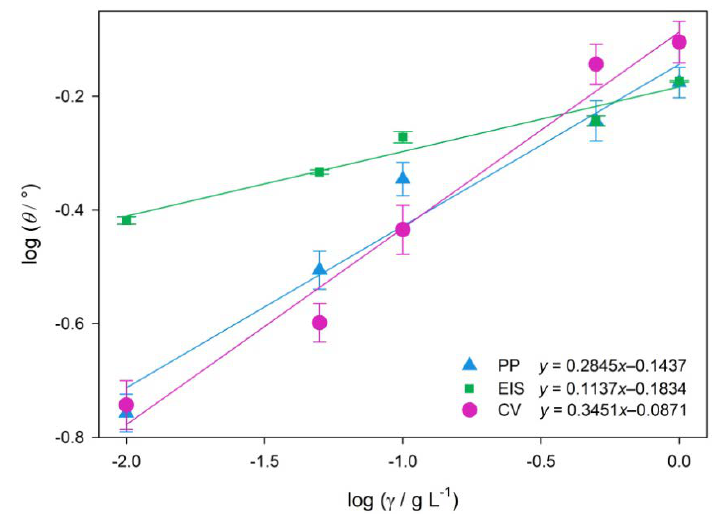
Figure 5 . Freundlich isotherms of adsorption of A. annua extracts on Al alloy 5083 surfaces in ASW. The adsorption constant, K, and the Gibbs free energy, ΔG , determined from PP, EIS and CV data using Equation (7) , were as follows: K = 0.718 and ΔG = −16.30 kJ mol − 1 (PP), K = 0.655 and ΔG = −16.07 kJ mol − 1 (EIS), K = 0.818 and ΔG = −16.62 kJ mol − 1 (CV).